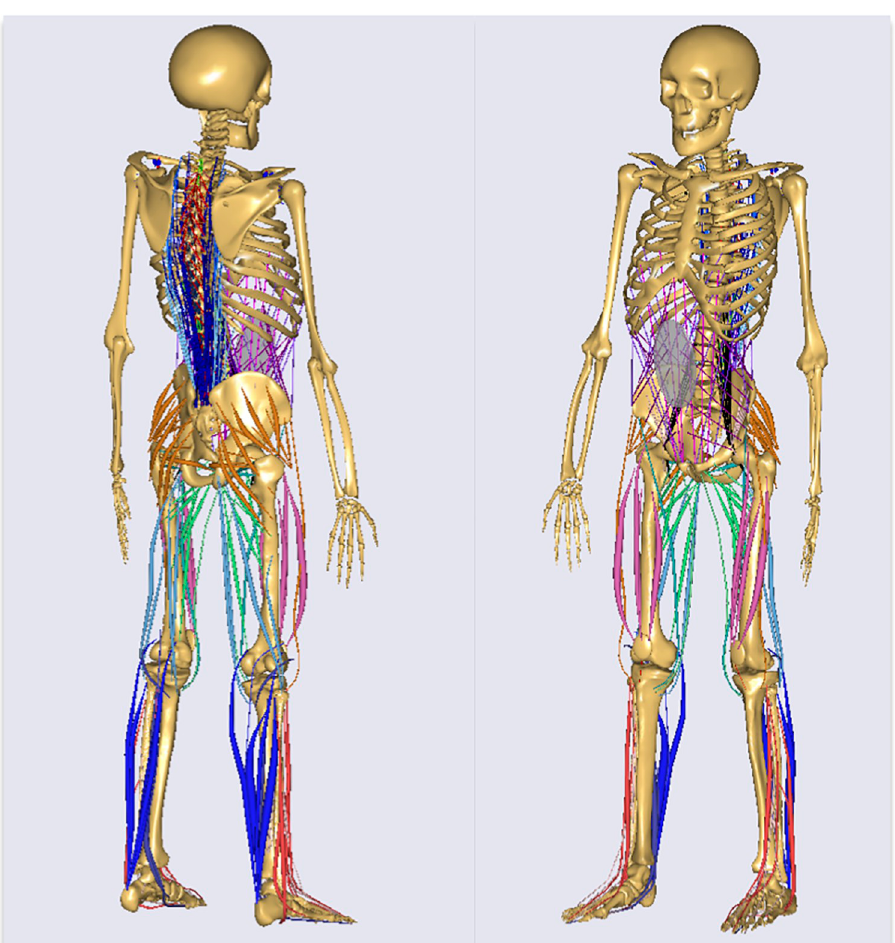
Fig 2. The constructed musculoskeletal model using the Anybody Modeling System. The constructed model altered the thorax, muscle attachment points, and